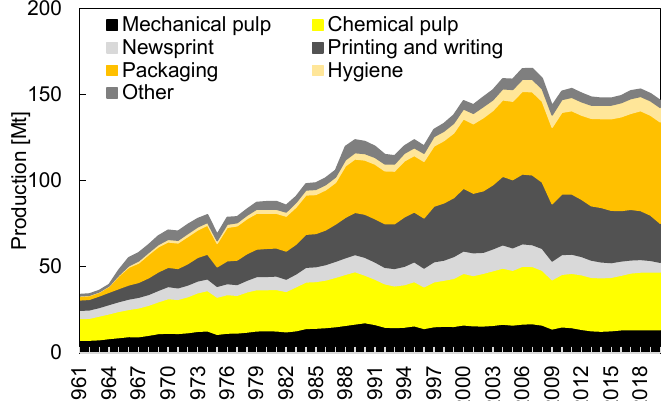
Figure 3. Development of pulp and paper production in the European pulp and paper industry. Data from FAO [24].